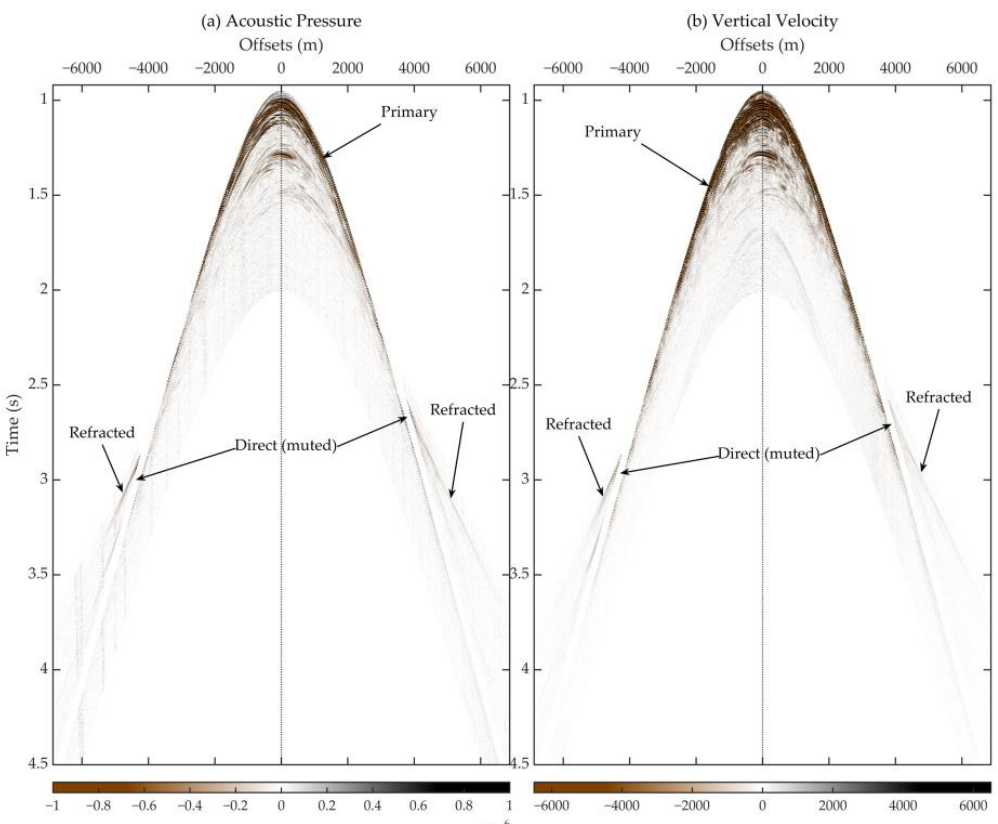
Figure 3. Critically-refracted and primary-reflected waves selected by data windows in the ( a ) acoustic pressure and ( b ) vertical velocity components. As implied by the gaps between refracted and reflected events, direct waves have been excluded.